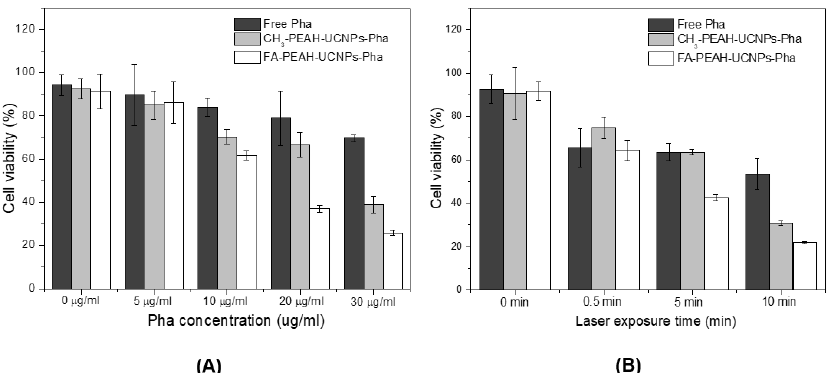
Figure 9. In vitro cytotoxicity test using free Pha and FA / CH 3 -PEAH-UCNPs-Pha against MCF7 cells, ( A ) phototoxicity depending on the Pha concentration; ( B ) phototoxicity depending on laser exposure time.